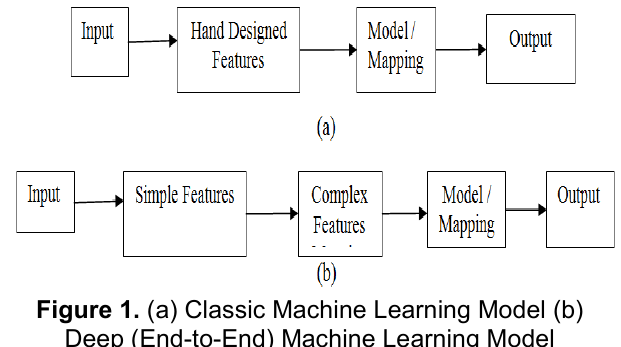
Figure 1. (a) Classic Machine Learning Model (b) Deep (End-to-End) Machine Learning